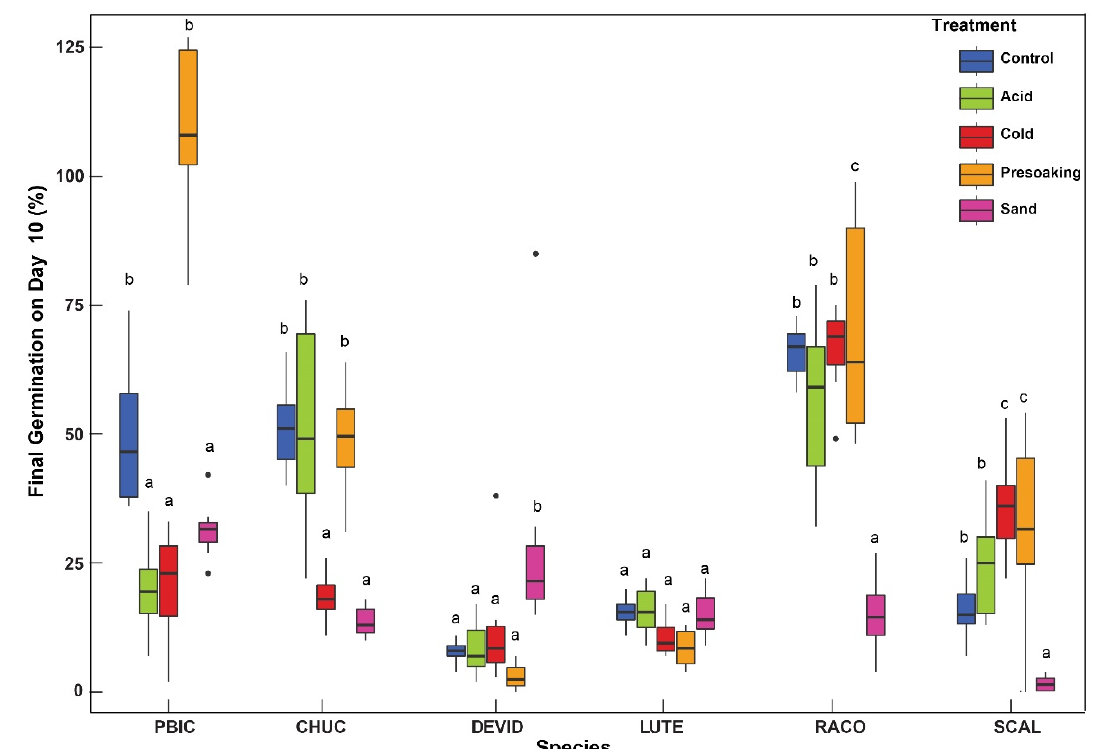
Figure 2. A representation of the final germination (FG) on day 10 for select species of germination >10%. Species meeting the standards included in this analysis are P. bicolor (PBIC) , C. cucullata (CHUC) , D. virgatus (DEVID, L. texensis (LUTE), R. columnifera (RACO), and S. calva (SICA). Significant differences in the final germination within each species were evaluated using multiple comparisons-adjusted Tukey’s HSD test.